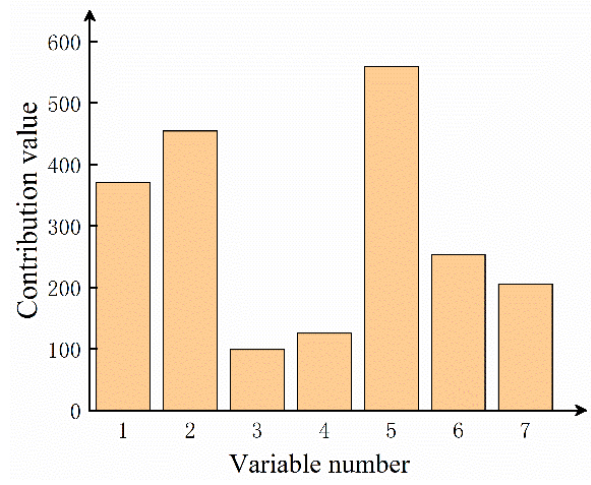
Figure 16. Traditional contribution plot of sample 1.